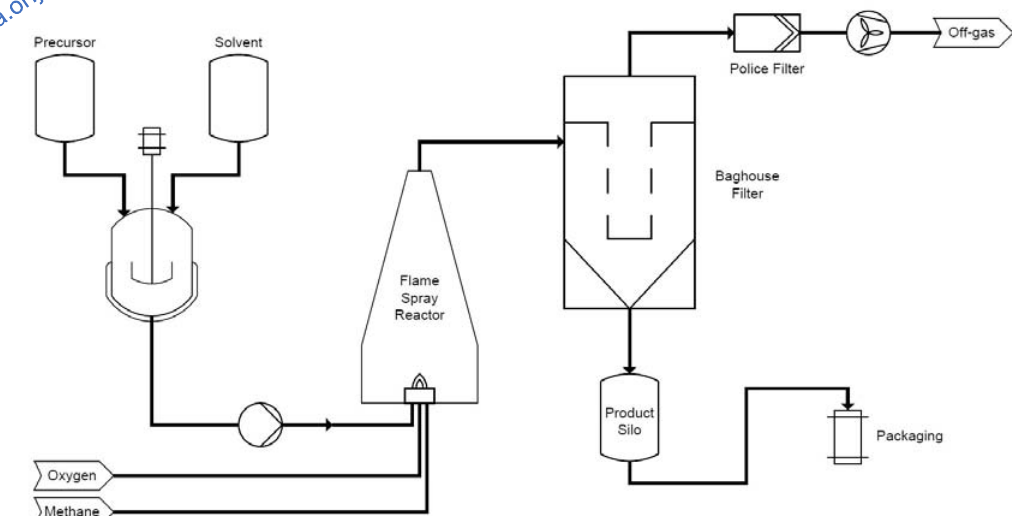
Fig. 1 Flow chart of a plant for nanoparticle synthesis by flame spray pyrolysis with stirred tank for precursor prepara- tion, FSP reactor, baghouse filter for nanoparticle collection and police filter for off-gas